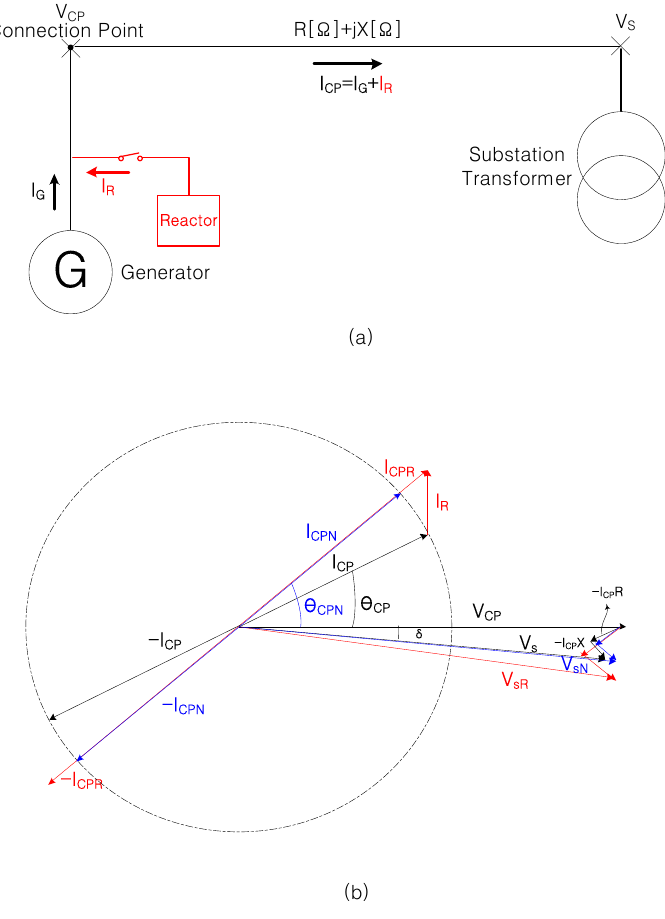
Figure 2. Grid-connected REG with reactor; ( a ) single line diagram; ( b ) vector diagram.